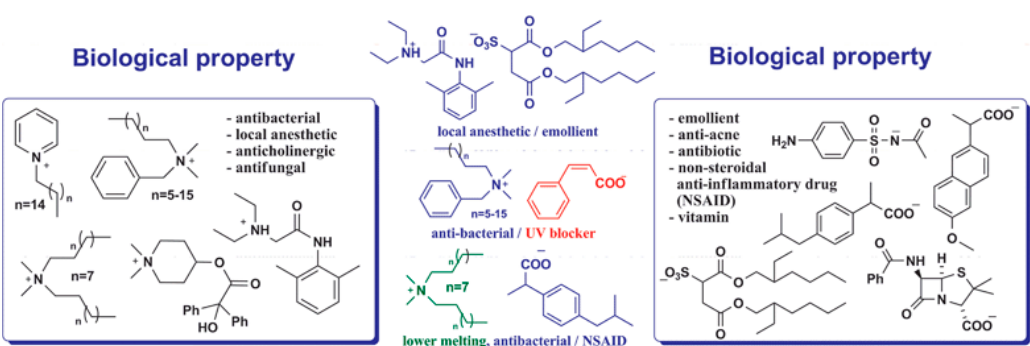
Figure 2. Evolution of the scientific focus on ILs from unique physical through unique chemical and now biological property sets. Reprinted with permission from [12].